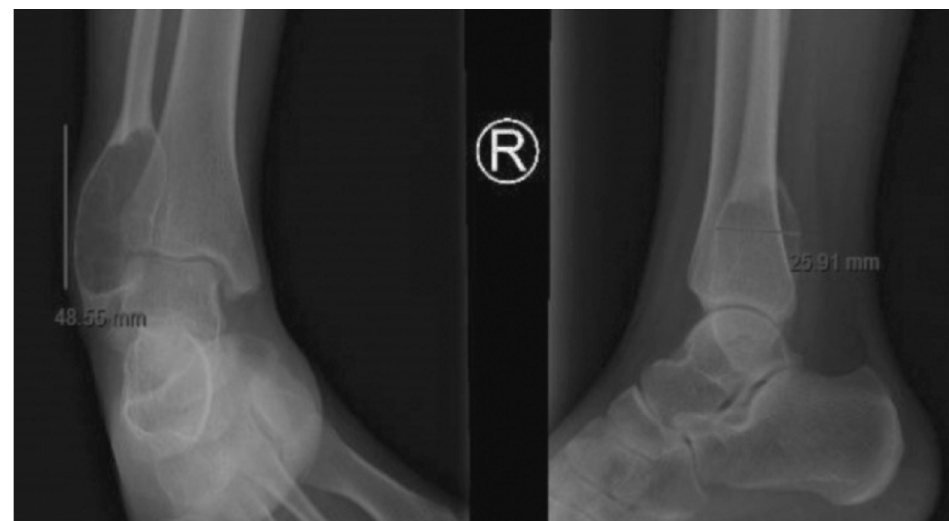
Plain radiograph of the ankle in anteroposterior and lateral views. Fig. 1: